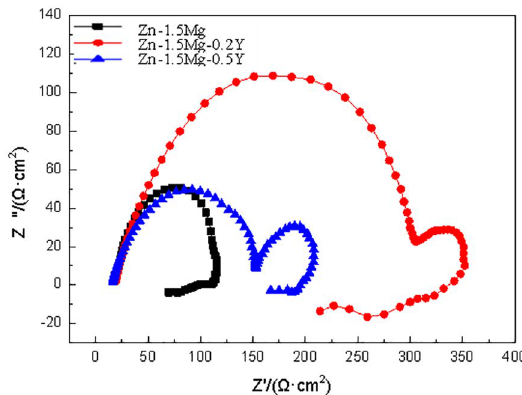
Figure 5. The electrochemical impedance spectroscopys (EIS) plot of Zn-1.5Mg-xY alloy samples in SBF solution. Table 3. CCK8 test results of mouse osteoblasts after 3days